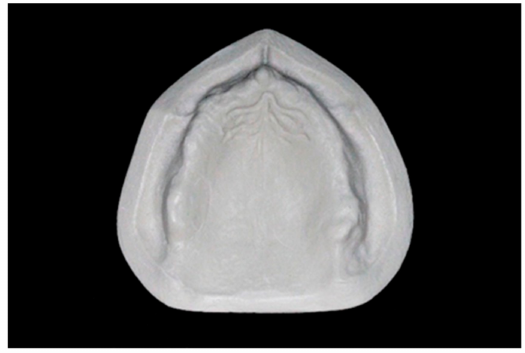
Figure 1. Reference typodont (RT) in polyurethane